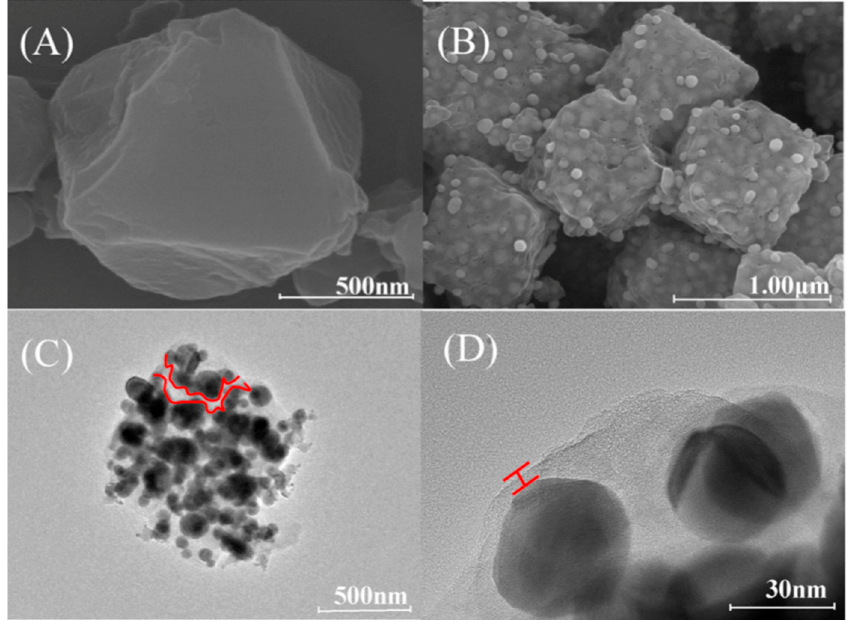
Figure 3. SEM images of the Cu 3 (BTC) 2 MOF precursor ( A ), and SEM ( B ) and TEM ( C , D ) images of Cu@graphitic carbon composite. Adapted with permission from [73]. Copyright (2018) Elsevier.